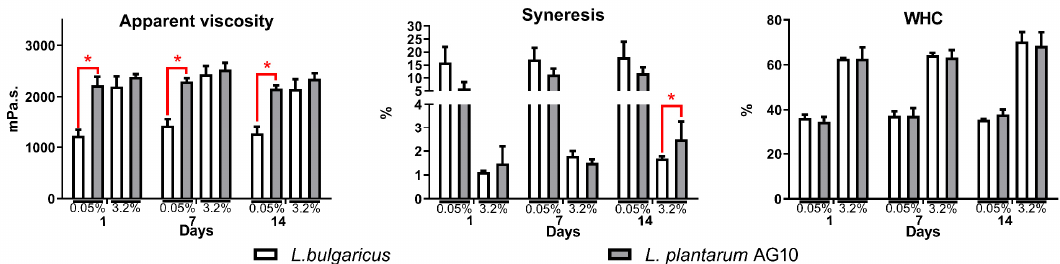
Figure 2. Textural characteristics of skimmed and whole milk fermented with either L. bulgaricus (shown in white) or L. plantarum AG10 (shown in gray) after 1, 7, and 14 days of storage. Asterisks show a significant difference at p < 0.05. The % of initial fat in the milk is shown under the X-axis.